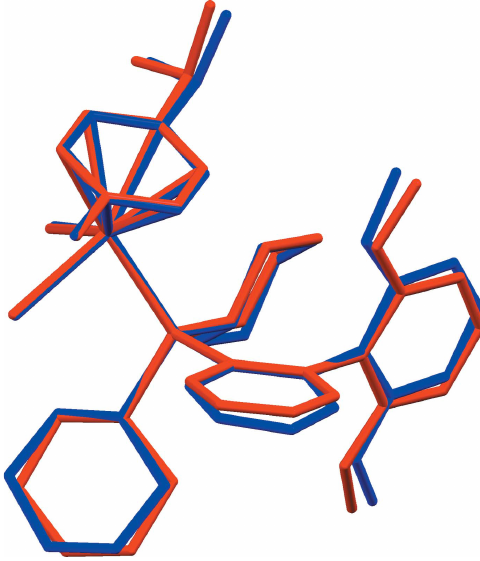
Figure 2 A view of the molecular overlap of the inverted molecule B (red) on molecule A (blue). H atoms have been omitted for clarity.